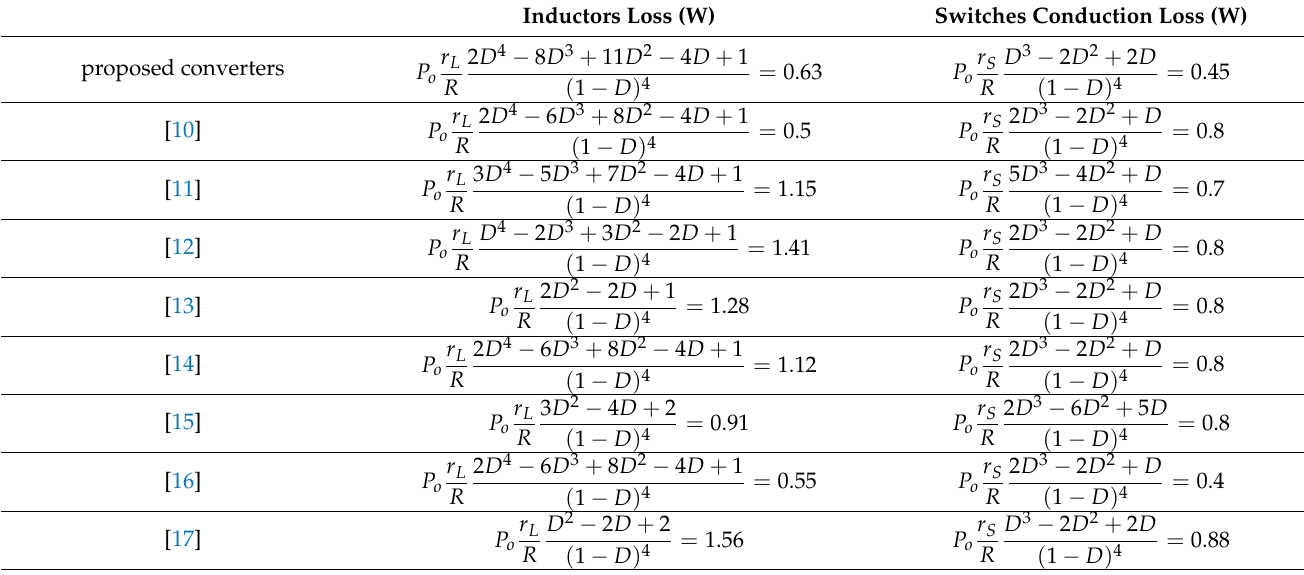
Table 1. Comparison of power loss of inductors and switches (conduction) as the voltage gain ratio equals 3. Inductors Loss (W) Switches Conduction Loss (W) proposed converters